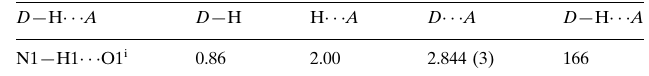
Hydrogen-bond geometry (A˚ , (cid:4)